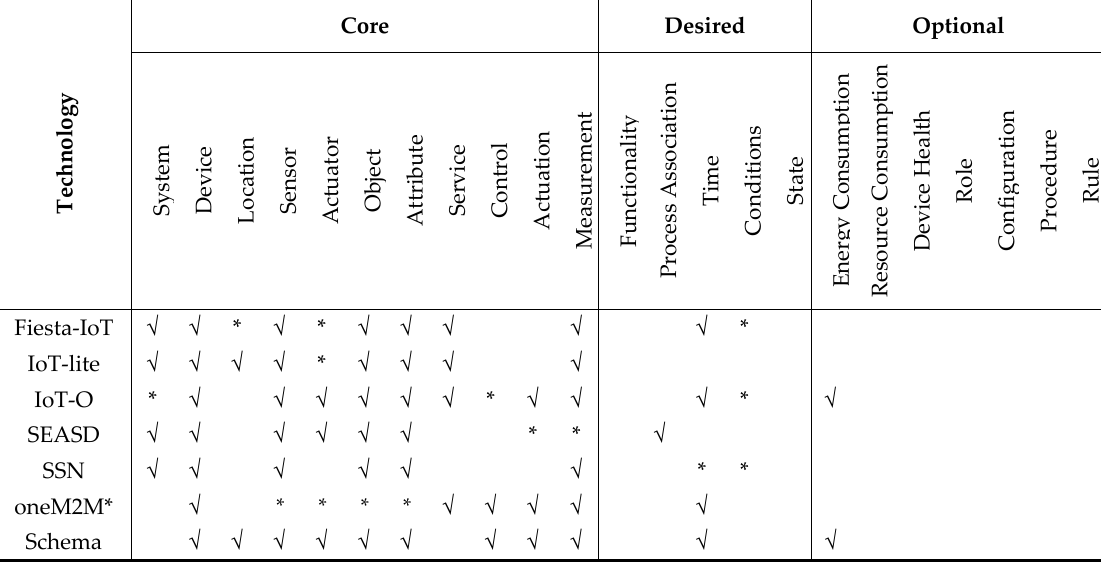
Table 3. Review of existing ontologies and schema.org.